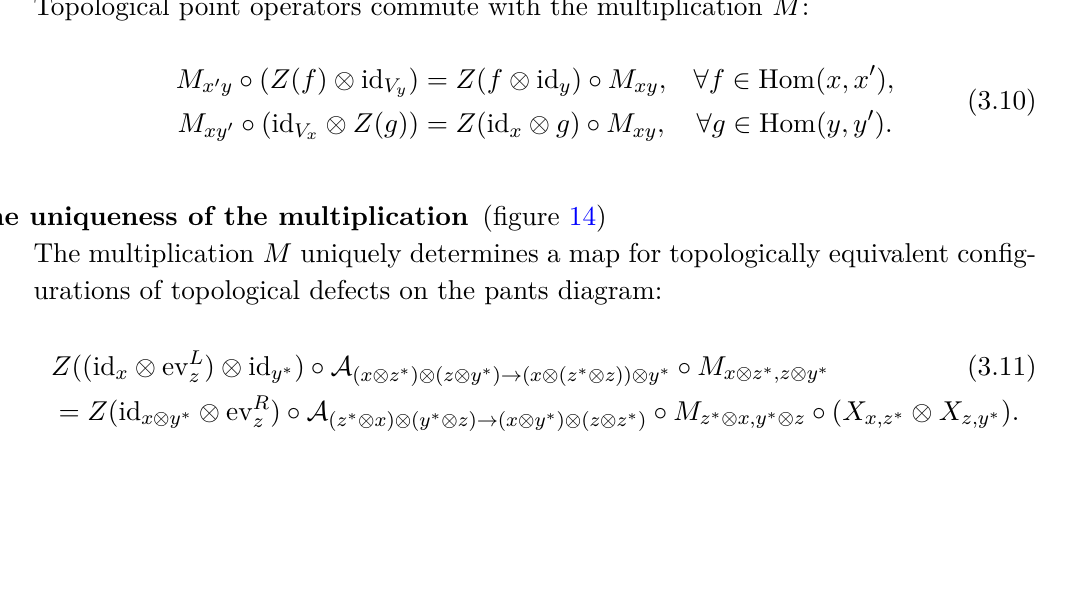
Figure 14 . The auxiliary line does not intersect with topological defects on the left-hand side, while it intersects with topological defect z three times on the right-hand side. They give the same transition